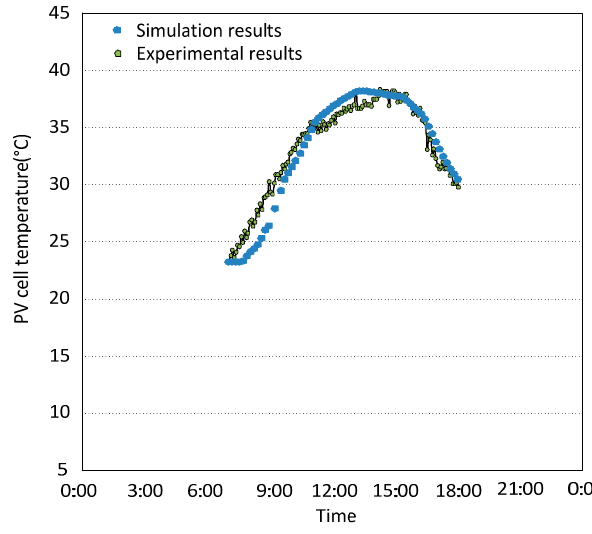
Figure 4. Comparison of the simulation results and experimental results.